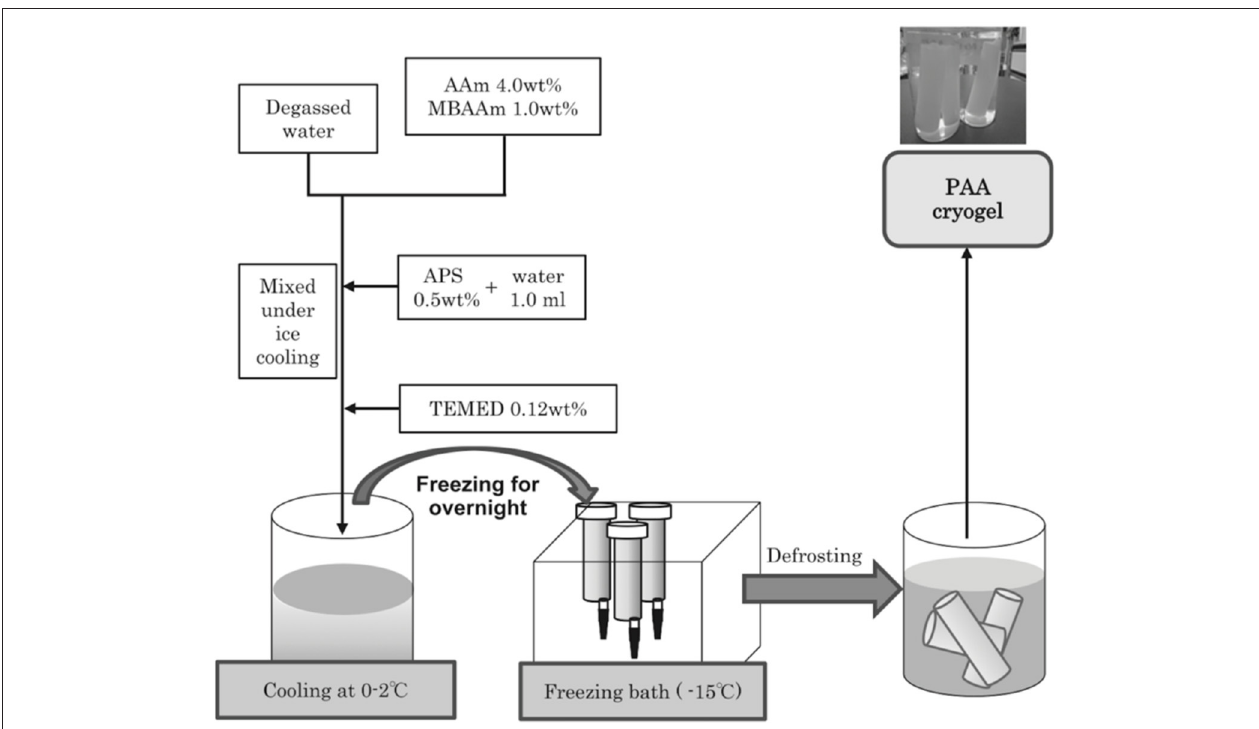
FIGURE 4 | Preparation of the polyacrylamide cryogel: polymerization system; a program controlled refrigerated ethanol bath and at − 15 ◦ C for 24h (Kurozumi et al., 2015